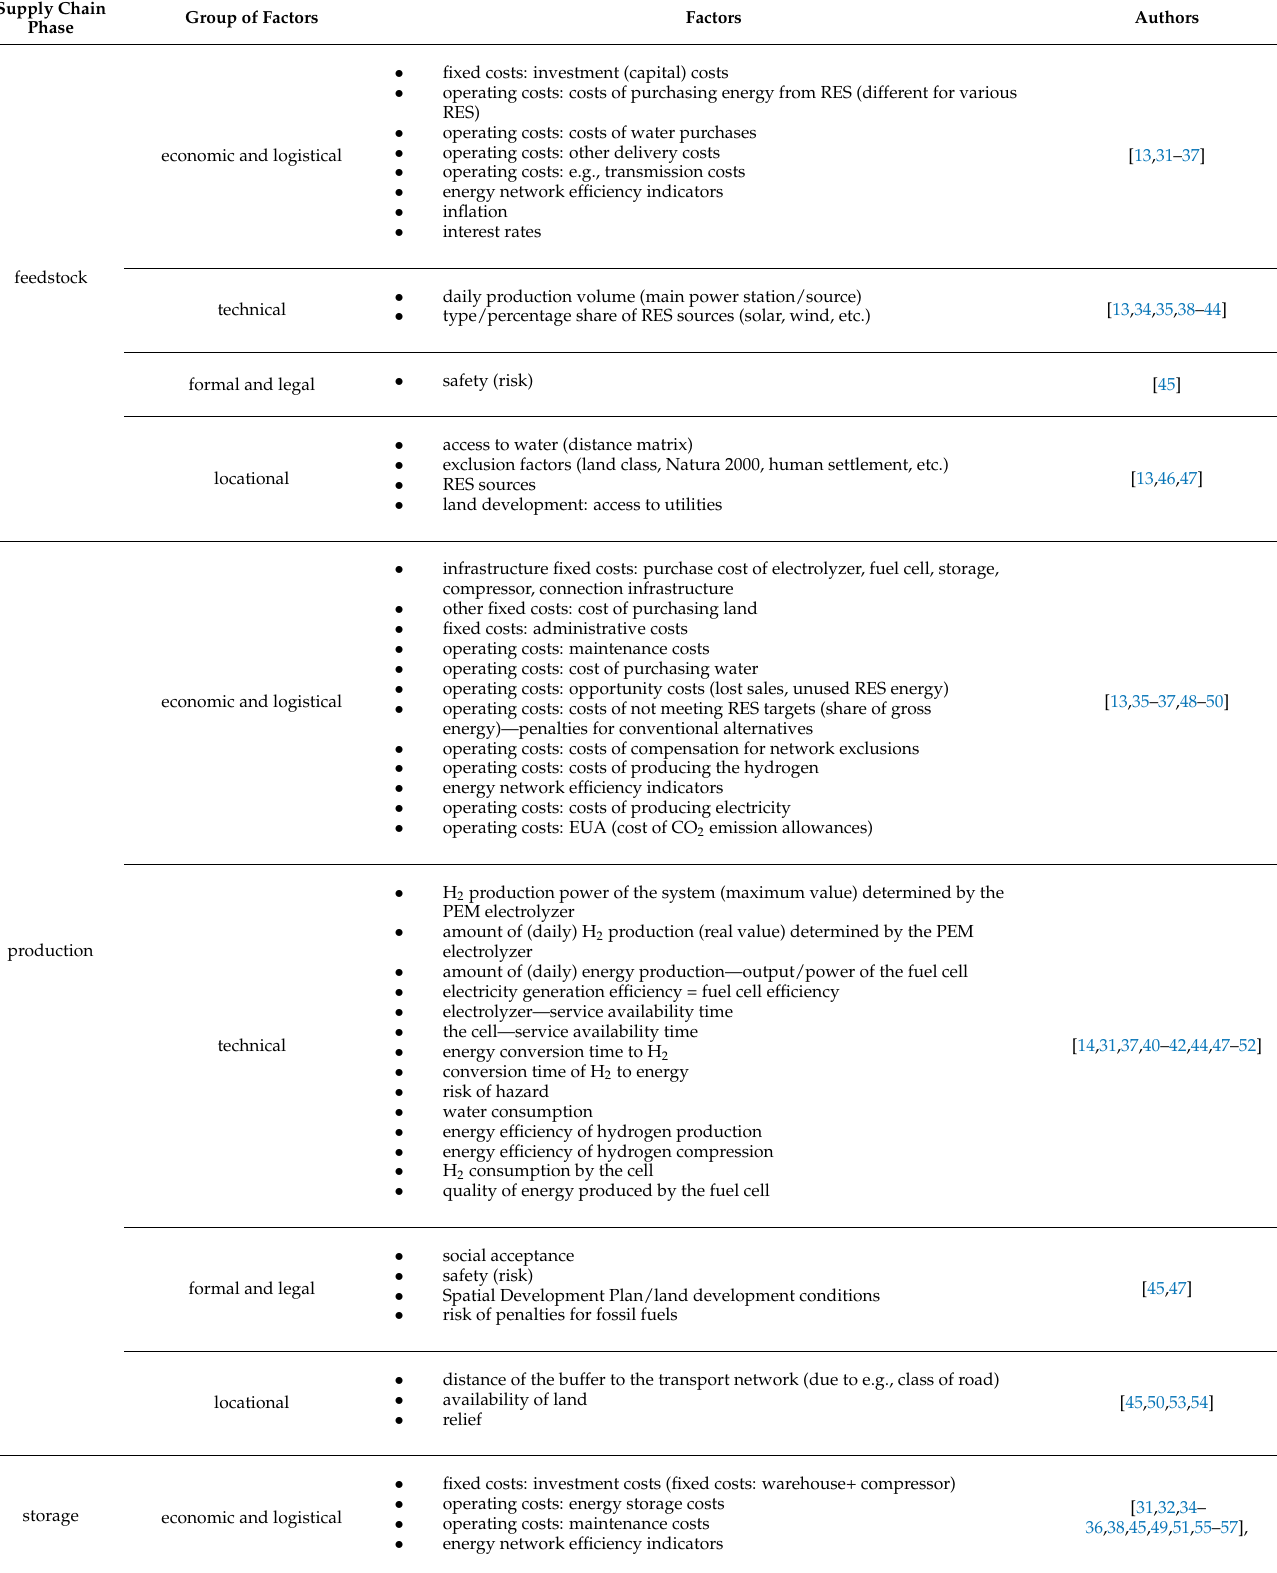
Table 1. Structural model factors derived from the conducted literature